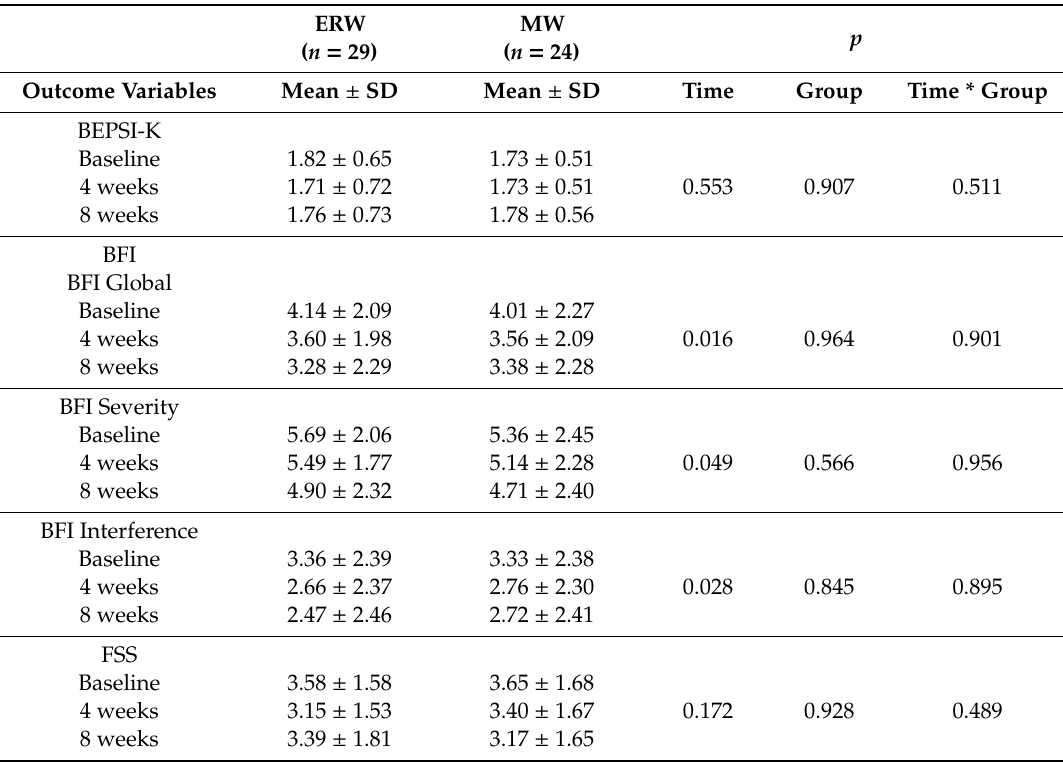
Table 5. E ff ects of treatment on the secondary outcome variables: BEPSI-K, BFI, FSS, and